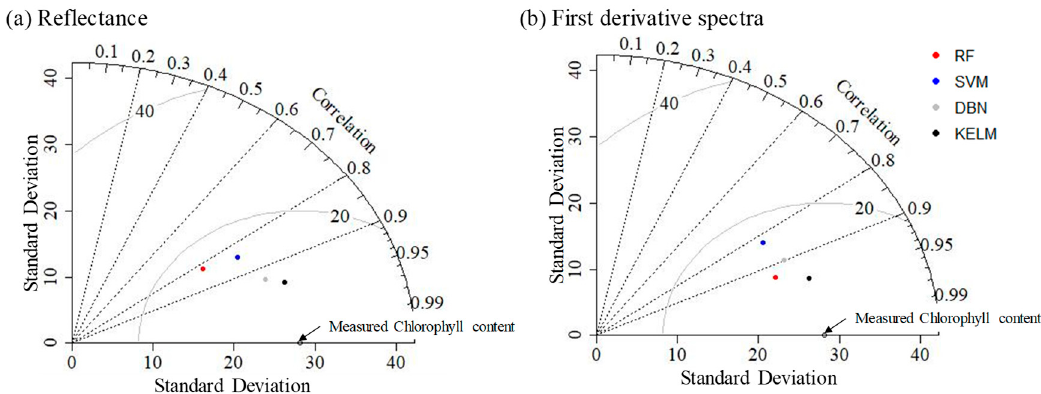
Figure 6. Taylor diagrams showing performances of regression models based on machine learning algorithms and ( a ) reflectance or ( b ) first derivative spectra. The grey counter indicates the root-mean-square error (RMSE) values. RF: random forest, SVM: support vector machine, DBN: deep belief nets, KELM: kernel-based extreme learning machine.